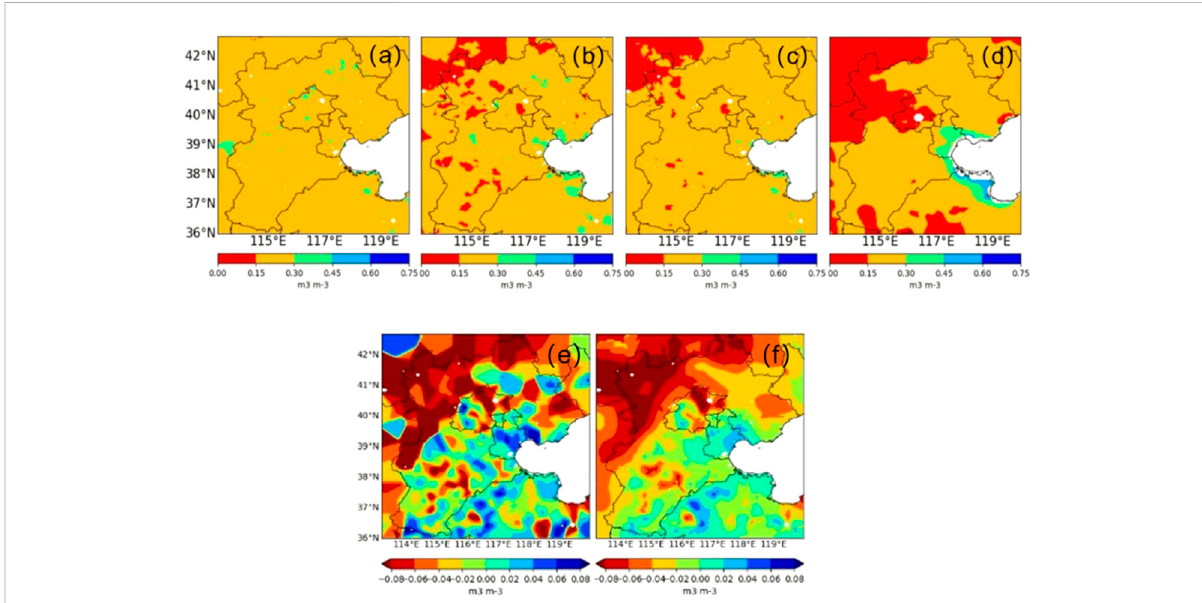
FIGURE 5 DistributionofmonthlyaveragesfromCtr (A) ,BARNES (B) ,CRESS (C) ,andSMAP (D) .Differencebetweenanalysis[i.e.,BARNESminusCtr (E) and CRESS minus Ctr (F) ].